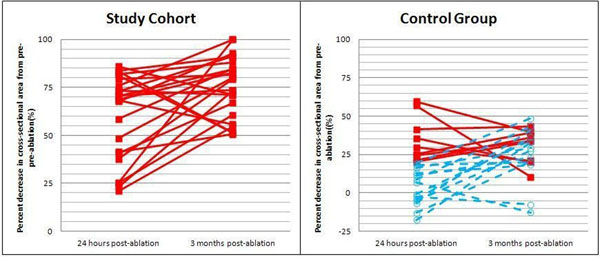
Percent decrease in pulmonary vein cross-sectional areas from pre-ablation at 24 hours post-ablation and 3 months post-ablation. Side-by-side comparison of study cohort to control group. Red solid lines representing patients with >20% narrowing at 24 hours post-ablation. Blue dashed lines representing patients with ≤20% narrowing at 24 hours post-ablation. Note: all of 23 patients in the study cohort had >20% pulmonary vein narrowing as compared to 9 of 23 patients in the control group at 24 hours post-ablation.